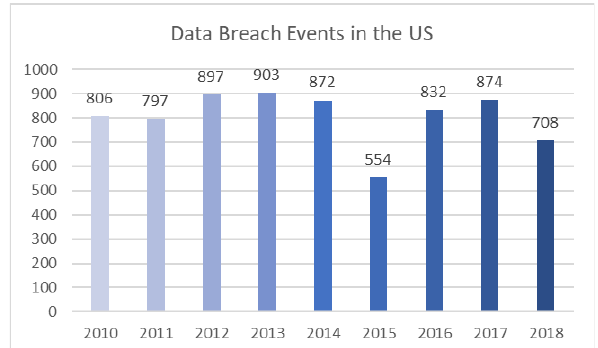
Figu re 3. Data breach events in American organizations from 2010 to 2018 (data source: privacyrights.org).